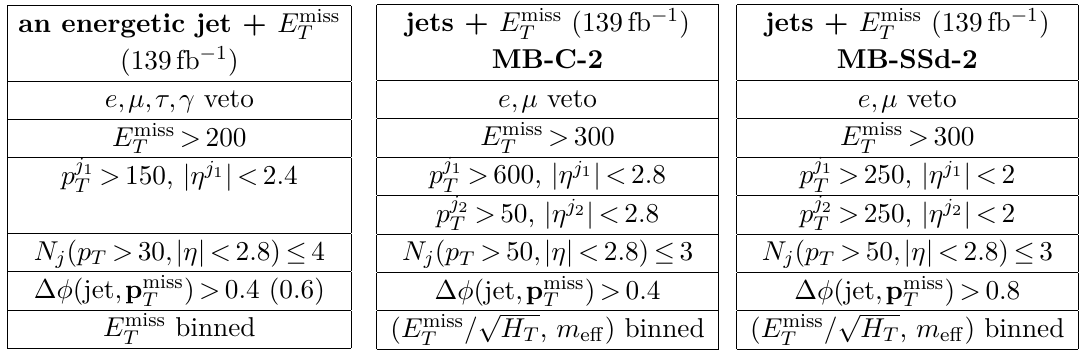
Table 1 . Event selection criteria in “an energetic jet + E miss MB-SSd-2 (right) signal regions in “jets + E miss threshold of ∆ φ cut is raised to 0.6 if E miss